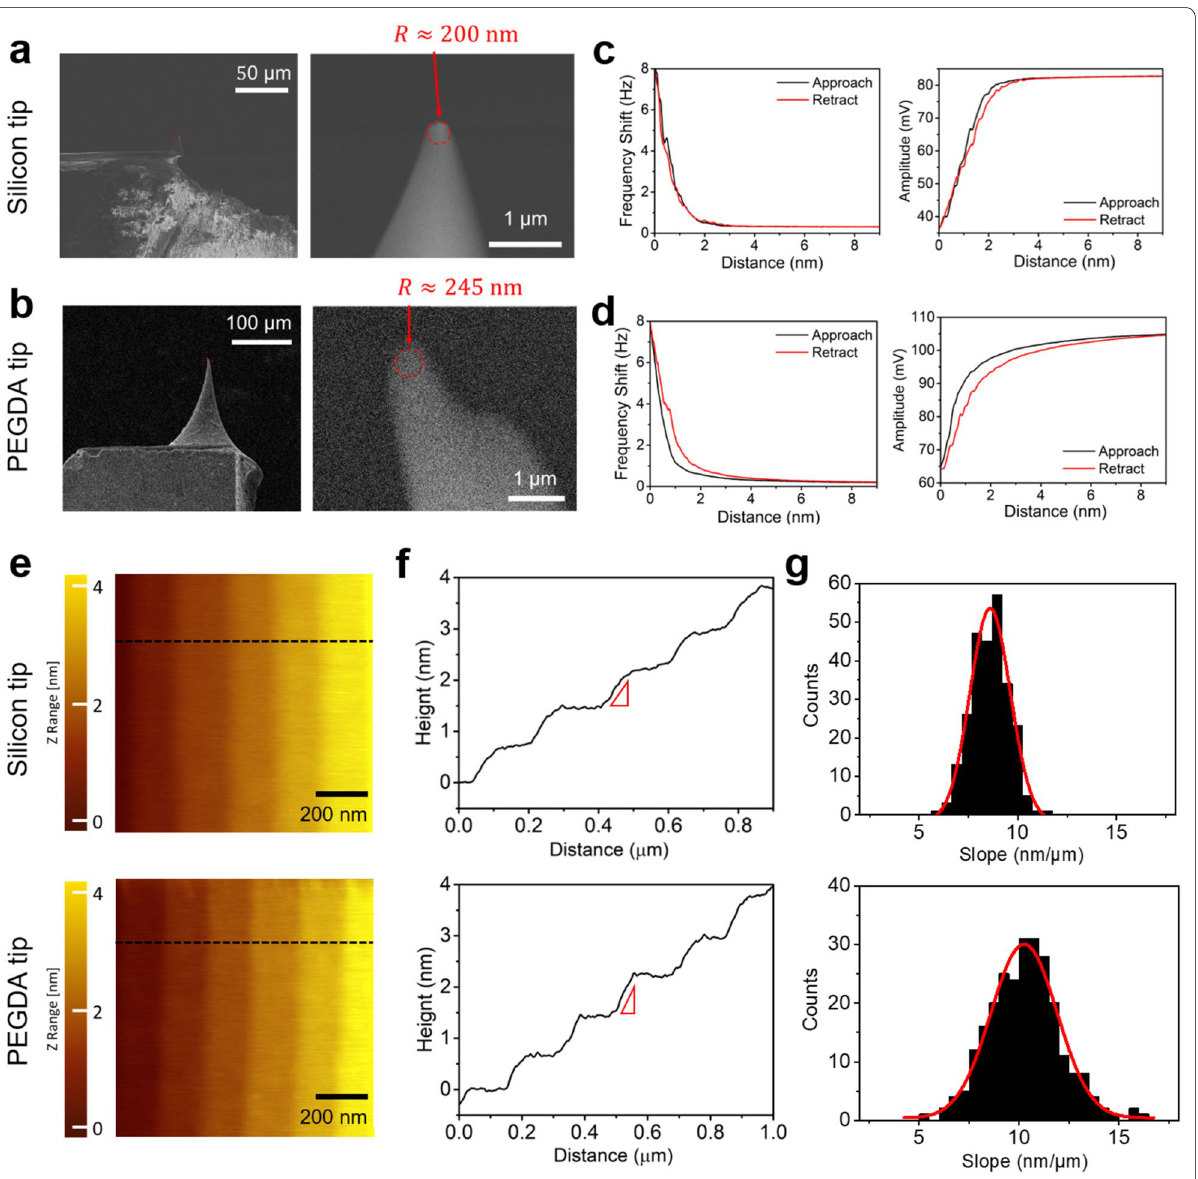
Fig. 4 Comparative SFM study for hexagonal silicon carbide (6H-SiC) sample by using silicon or PEGDA tip attached quartz tuning forks with similar tip radii. SEM images of a a commercial silicon tip and b a PEGDA tip attached quartz tuning forks. Left and right images are taken at low and high magnification, respectively. QTF’s resonance frequency and amplitude shift for the approach and retract cycle over a 6H-SiC sample with c the silicon tip attached and d PEGDA tip attached QTFs. e Dynamic mode topography, f linescans along the black dotted lines, and g histograms of the transition slope for the 3rd step (between the 3rd and 4th atomic layers) of the 6H-SiC. The first and second rows are for the silicon tip attached and PEGDA tip attached QTFs,